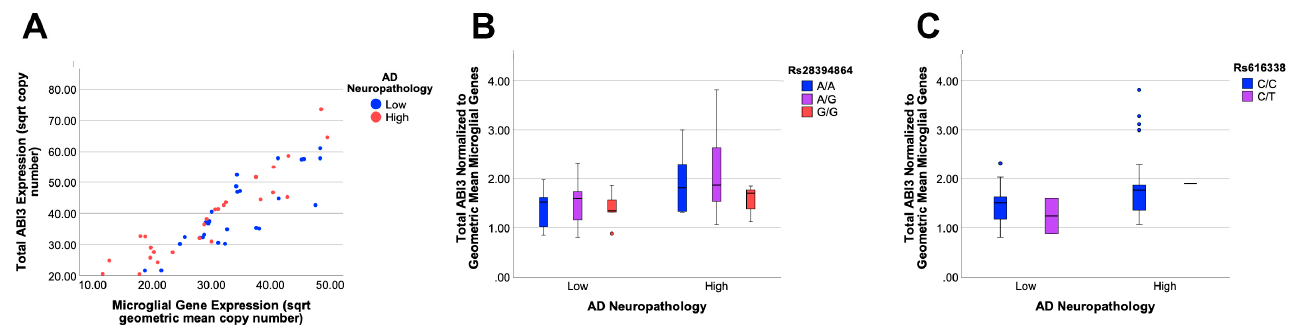
Figure 3. Total ABI3 expression increases with high AD neuropathology. ABI3 expression corre- lates strongly with the expression of microglial genes, which are modeled here as the geometric mean of AIF-1 and ITGAM expression ( A ). ABI3 expression in samples with high AD neuropathology was higher than those with low neuropathology ( p = 0.02). The number of samples with high and low pathology was 26 and 27, respectively. ABI3 expression was not modulated by either SNP. Dots represent outliers which are 1.5 times more than the interquartile range. ( B , C ). The number of samples for each genotype were: rs2894864 (G/G = 16, G/A = 23, A/A = 14), and rs616338 (C/C = 50, C/T = 3).